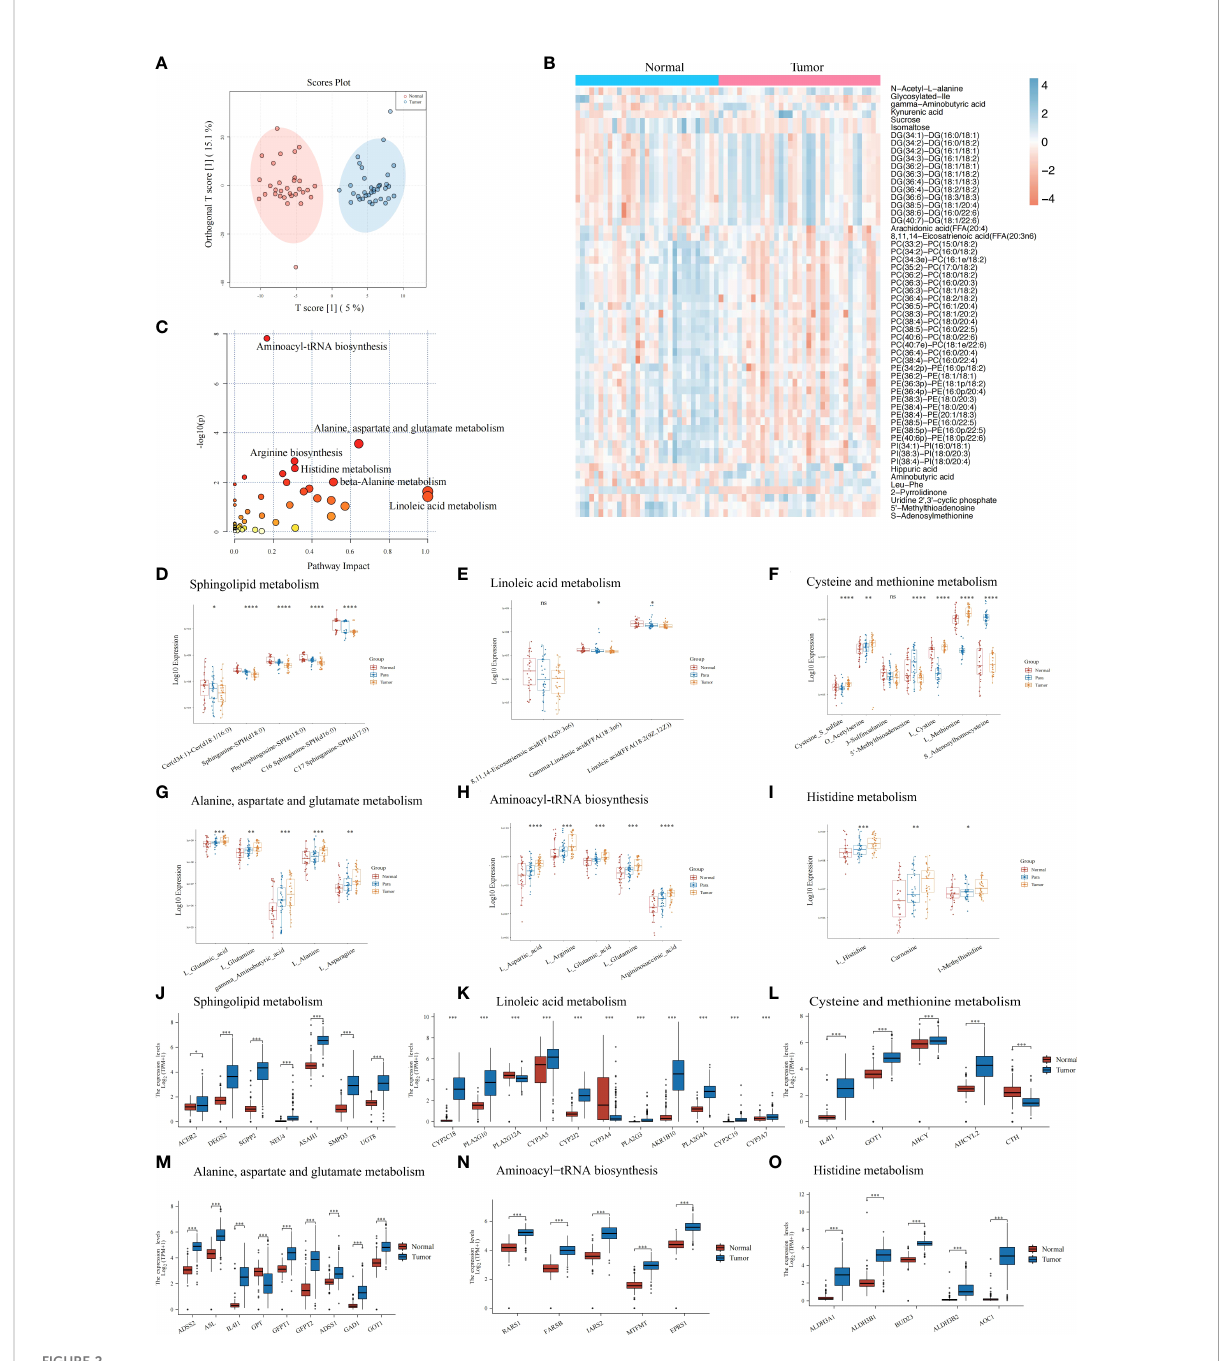
FIGURE 2 Metabolic features of the pancreatic tumor tissues, paired para-carcinoma tissues, and paired normal pancreatic tissues. (A) Orthogonal partial least squares discrimination analysis (OPLS-DA) score scatter plot of pancreatic tumor tissues and normal pancreatic tissues. (B) Heatmap of 233 with signi fi cant changes by comparing pancreatic tumor tissues and normal pancreatic tissues. Blue, increased metabolite. Orange, decreased metabolite. (C) KEGG pathway analysis of the 233 signi fi cantly changes metabolites mentioned above. (D – I) Metabolites expression in three groups (pancreatic tumor tissues, paired para-carcinoma tissues, and paired normal pancreatic tissues) involved in sphingolipid metabolism (D) , linoleic acid metabolism (E) , cysteine and methionine metabolism (F) , alanine, aspartate, and glutamate metabolism (G) , aminoacyl-tRNA biosynthesis (H) , and histidine metabolism (I) . (J – O) TCGA plus GTEx online results showed that genes differentially expressed in normal and tumor pancreatic tissues are also involved in sphingolipid metabolism (J) , linoleic acid metabolism (K) , cysteine and methionine